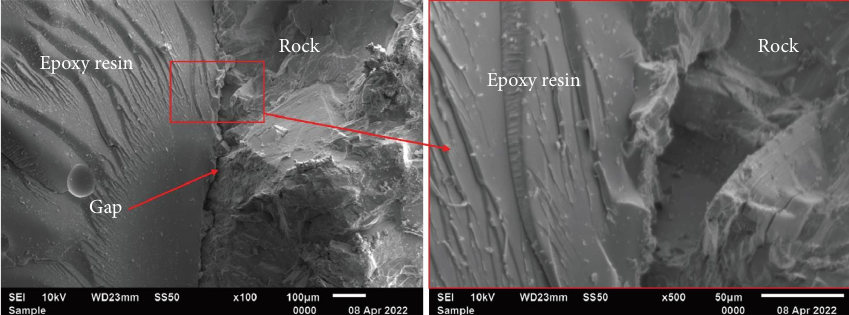
Figure 26: SEM image of the failed bond surface with 14d of